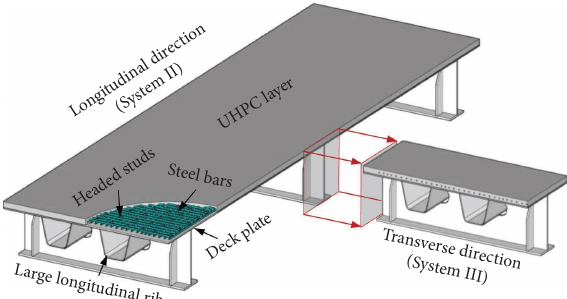
Figure 2: Te steel–UHPC composite bridge deck with large longitudinal